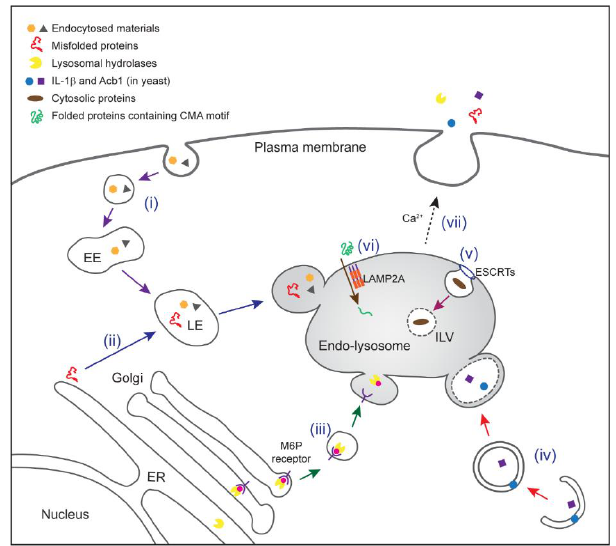
Figure 1. Multiple protein trafficking pathways to endo-lysosomes. ( i ) Endocytic trafficking. Fluid, solutes, macromolecules, plasma membrane components, and viruses can be internalized by invagination of the plasma membrane, forming vesicles. The vesicles fuse with each other, forming early endosomes (EEs) where cargo sorting occurs. Early endosomes move towards a perinuclear region and mature into late endosomes (LEs) as a result of continued membrane fusion, fission, and luminal acidification. A fraction of late endosomes bearing intraluminal vesicle (ILV) (endo-lysosome) may not have acquired a degradative function, and is rather specialized in protein secretion. Other late endosomes may fuse with lysosomes to degrade their contents. ( ii ) Misfolding-associated protein secretion (MAPS). Misfolded proteins are recruited to the endoplasmic reticulum (ER) surface by an ER-bound protein with a chaperone activity (e.g., Ubiquitin carboxyl-terminal hydrolase 19). Misfolded proteins are then transported into the lumen of endo-lysosomes for secretion. ( iii ) M6P receptor (MPR)-mediated delivery of lysosomal hydrolases. Most lysosomal enzymes undergo a mannose-6-phosphate (M6P) modification (pink circle) in the Golgi compartment. This allows them to bind to a MPR for sorting towards endo-lysosomes. In acidified endo-lysosomes, cargos are released from the receptor for delivery to lysosomes. Some of lysosomal hydrolases can be secreted to the extracellular space under specialized conditions probably via secretory endo-lysosomes. ( iv ) Secretory autophagy. Upon starvation, a compartment for unconventional protein secretion (CUPS; possibly equivalent to omegasomes in mammals) is formed near the ER exit sites to capture secretory cargos (e.g., IL-1 β in mammal or Acb1 in yeast). GRASPs (Golgi reassembly and stacking proteins; Grh1 in yeast) and ATG proteins facilitate this process. Receptors that capture specific cargos have not been defined. Cargo-containing vesicles may fuse directly with the plasma membrane or first fuse with a secretory endo-lysosome prior to protein secretion. ( v ) Microautophagy (endosomal microautophagy in mammals). Cytosolic proteins are engulfed by invagination of endo-lysosomal membrane in either selective or non-selective manner. The initiation of microautophagy is mediated by several endosomal sorting complex required for transport (ESCRT) complexes. ( vi ) Chaperone-mediated autophagy (CMA). Heat shock cognate 71 kDa protein (HSC70) recognizes KFERQ-like motif in cytosolic proteins and targets them to lysosome-associated membrane protein 2A (LAMP2A). Multimerization of LAMP2A facilitates translocation of cargos in an unfolded form. CMA cargos are thought to be bound to lysosomal degradation. ( vii ) Endo-lysosomes or small vesicles derived from endo-lysosomes fuse with the plasma membrane in a Ca 2+ -dependent manner, which contributes to both conventional and unconventional protein